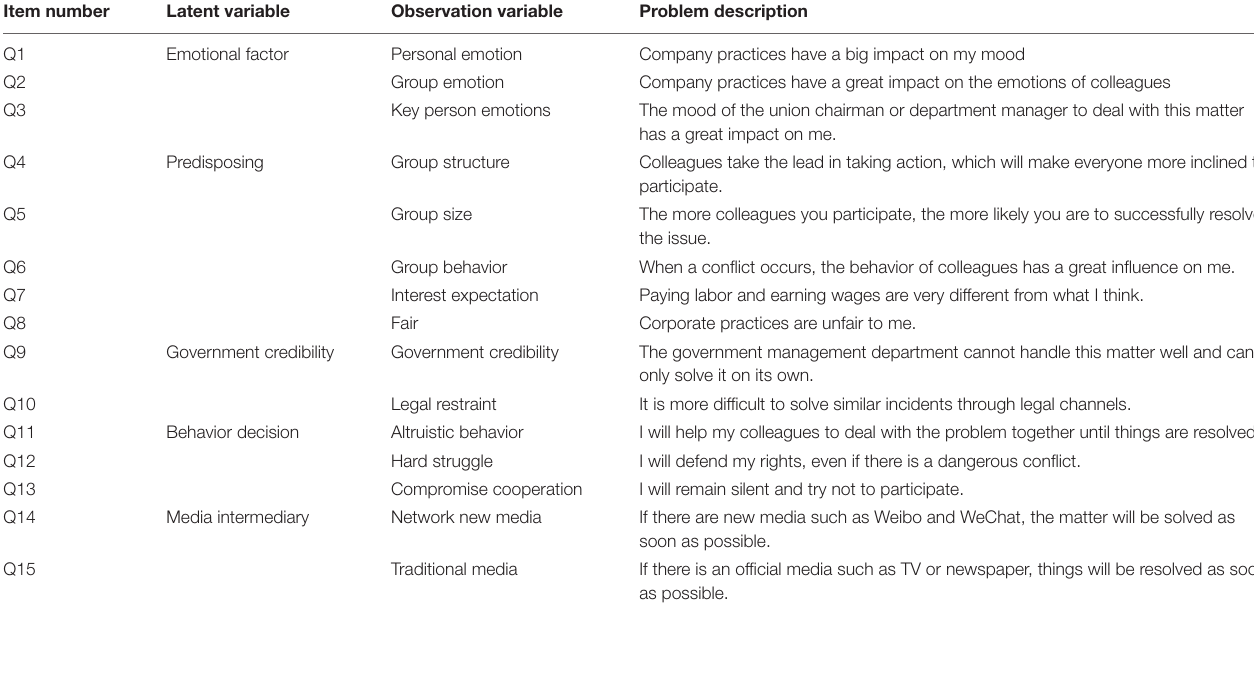
TABLE A1 | Questionnaires items of all study